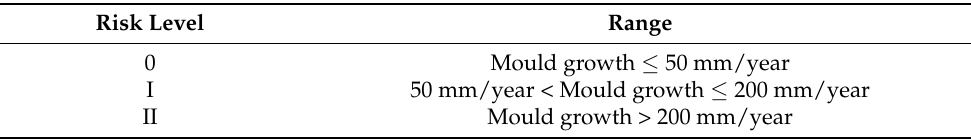
Table 3. Risk levels associated with mould growth in a year.